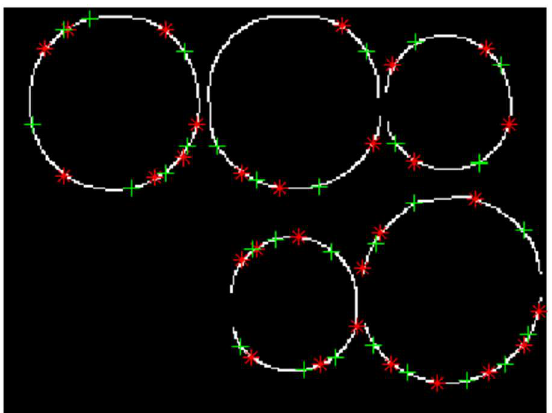
Figure 3. The distribution of information points on the image, where ‘*’ represents information point calculation parameters, and ‘+‘ represents information point verification parameters.